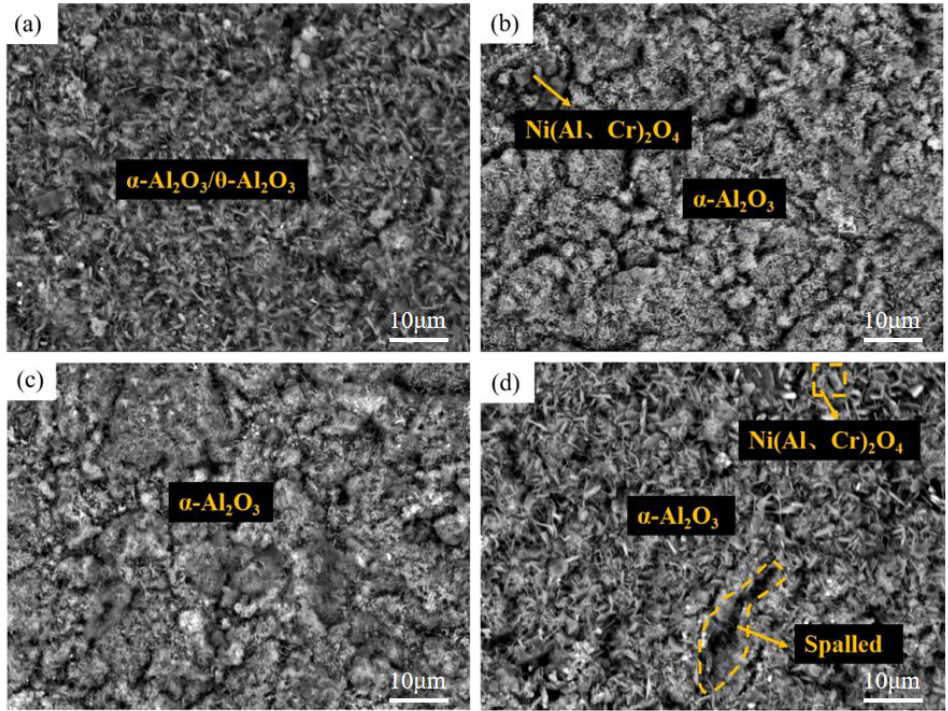
Figure 13. Surface morphologies of Al-Si coatings with different pre-oxidation times at 950 ◦ C: ( a ) 3 h; ( b ) 5 h; ( c ) 7 h; ( d ) 9 h.